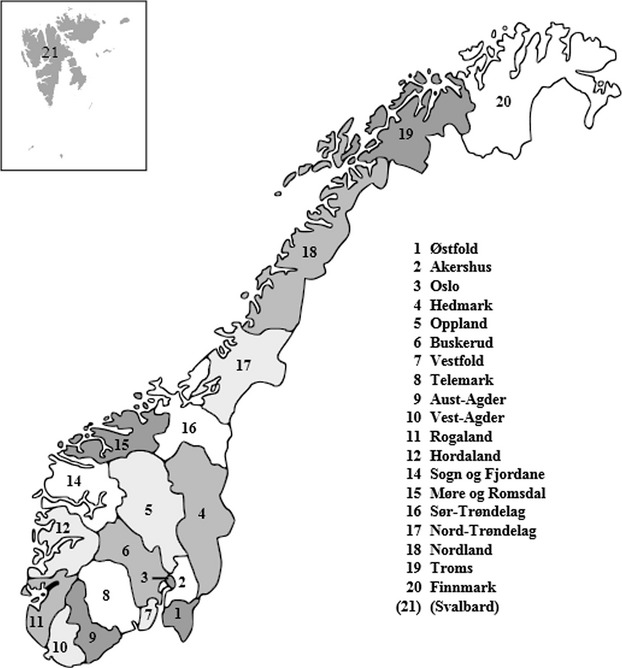
Counties in Norway.